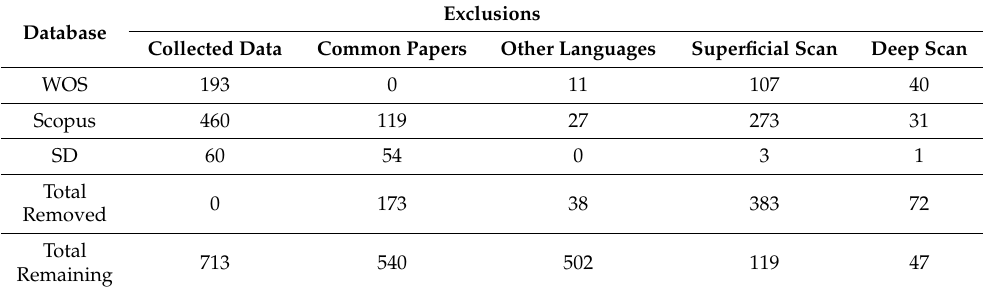
Table 2. Publication’s exclusion summary.